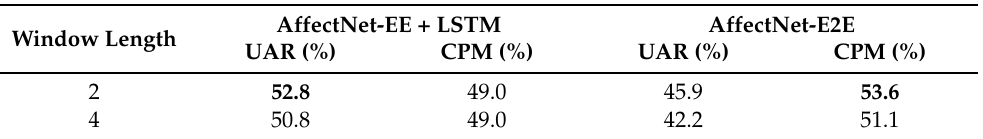
Table 5. The classification performance comparison of the fully end-to-end (AffectNet-E2E) and separate model training (AffectNet-EE + LSTM) approaches on the AffWild2 validation set. The best result within the system is highlighted in